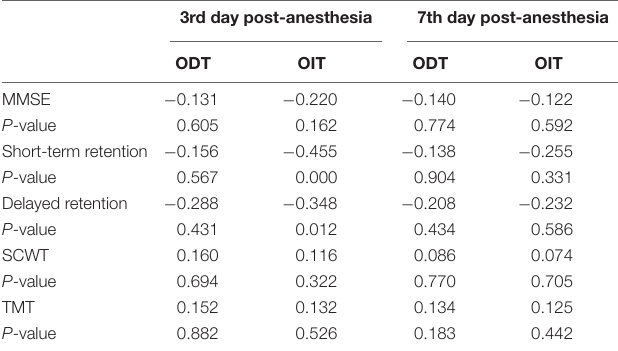
TABLE 5 | Spearman correlation analysis of olfactory function and cognitive function in the surgical group ( r- value).